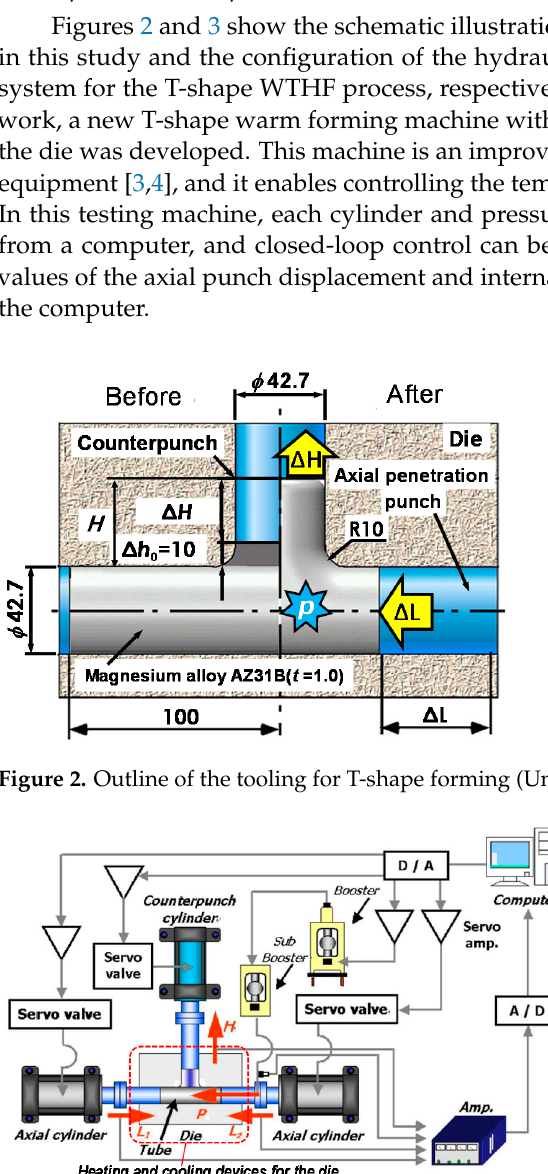
Figure 1. Stress-strain curves of AZ31 and AZ61 at different temperatures and initial strain rates. ( a ) AZ31B initial strain rate: 0.001 s − 1 ; ( b ) AZ31B, 0.1 s − 1 ; ( c ) AZ61, 0.01 s − 1 .